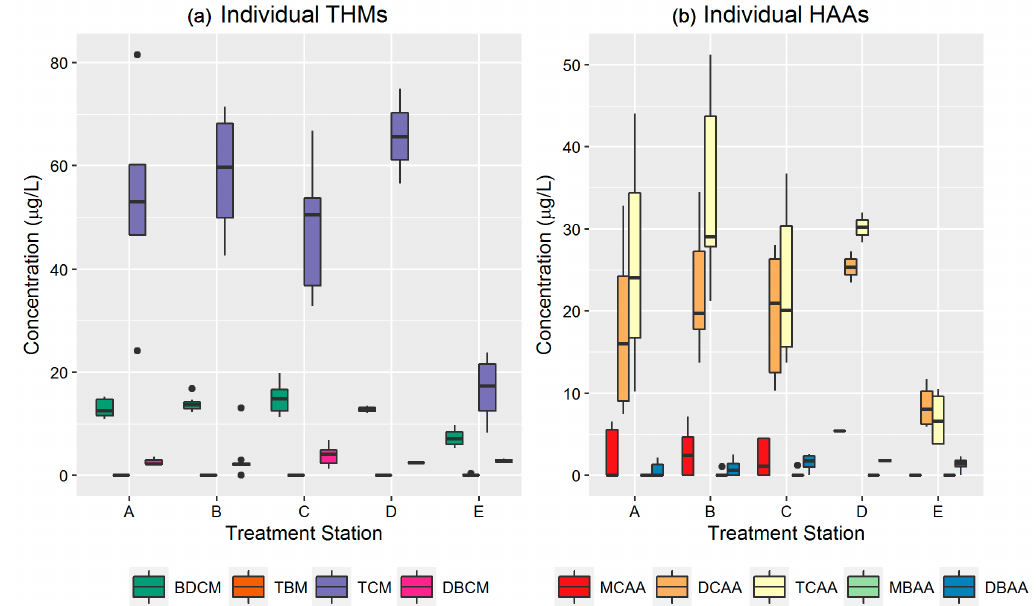
Figure 4. Spatial distribution of ( a ) individual THMs and ( b ) HAAs. BDCM = bromodichloromethane, TBM = bromoform, TCM = chloroform, and DBCM = dibromochloromethane. MCAA = monochloroacetic acid, DCAA = dichloroacetic acid, TCAA = trichloroacetic acid, MBAA = monobromoacetic acid, and DBAA = dibromoacetic acid. The boxplots above utilize Tukey-style whiskers in that the upper whisker extends from the upper hinge (75th percentile) to the highest value that is within 1.5 × IQR of the hinge and the lower whisker extends from the lower hinge (25th percentile) to the lowest value within 1.5 × IQR of the hinge. The black dots are outlier data points (outside the 1.5 × IQR range).